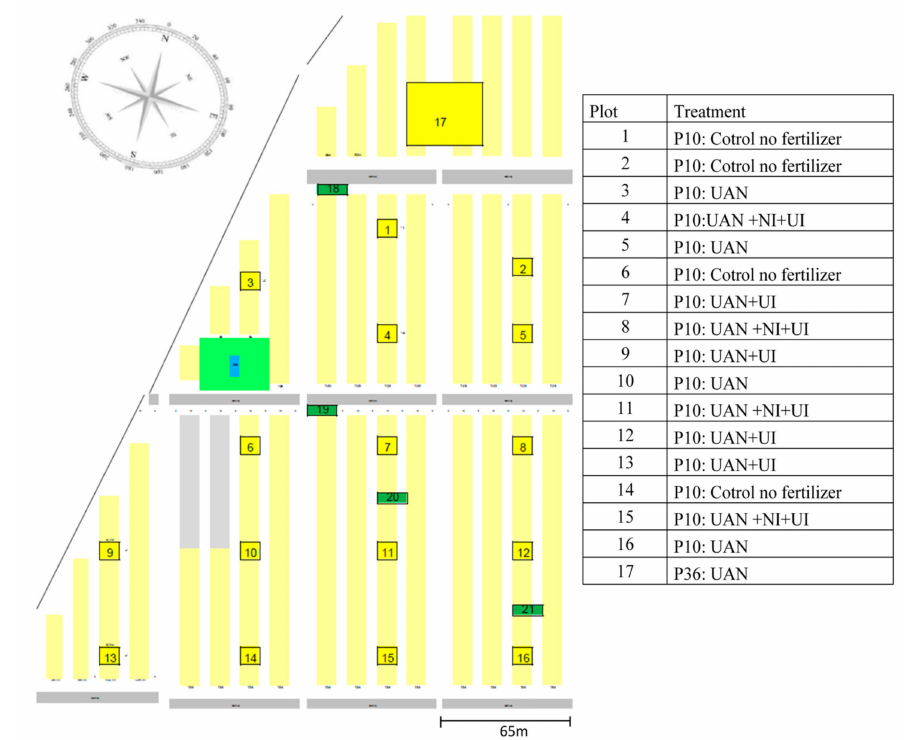
Figure 1. Location of plots and NH 3 -ALPHA samplers (passive di ff usion samplers measuring NH 3 concentration) for background measurements in March and April on the field in AArslev. The P10 plots (10 × 10 m 2 ) are given the numbers 1–16 and the P36 plot (36 × 36 m 2 ) number 17, i.e., plot